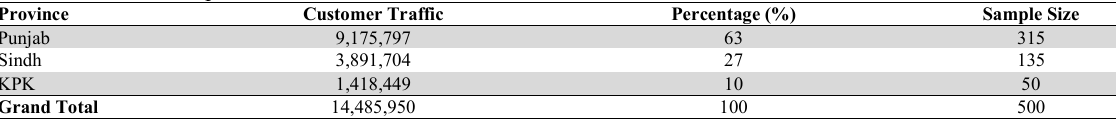
Determination of Sample Size for each cluster